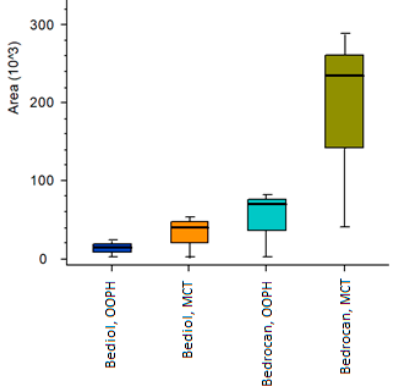
Figure 5. ∆ 9 -Tetrahydrocannabiphorol ( ∆ 9 -THCP) relative amount expressed as the normalized peak Figure 5. Δ 9 -Tetrahydrocannabiphorol ( Δ 9 -THCP) relative amount expressed as the normalized peak area in investigated oleates . Data are reported as median with 25th–75th percentile range on three area in investigated oleates. Data are reported as median with 25th–75th percentile range on three biological repetitions. biological